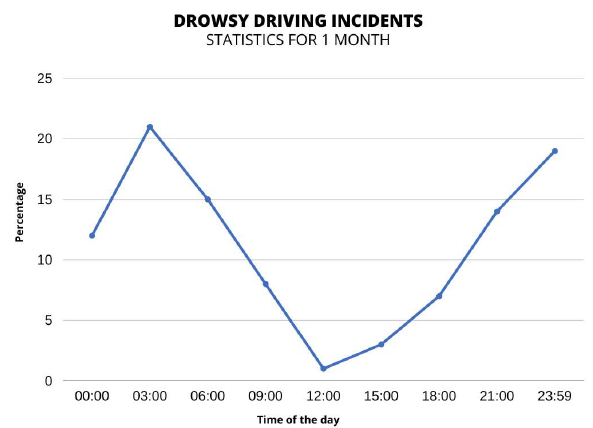
Figure 9: Percentage